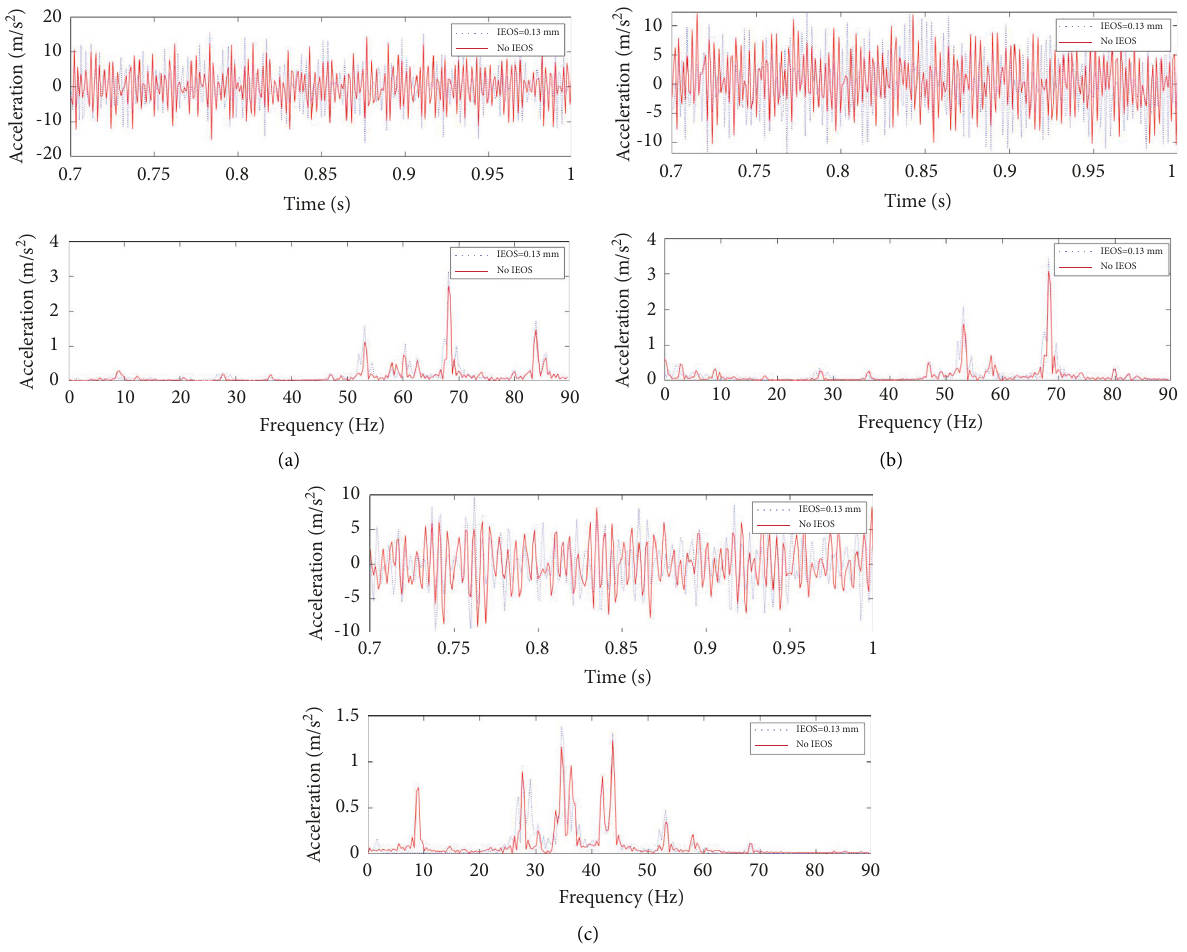
Figure 5: Vibration acceleration responses for sun gear under the IEOS of the 1st planet gear. (a) Horizontal direction. (b) Vertical direction. (c) Axial